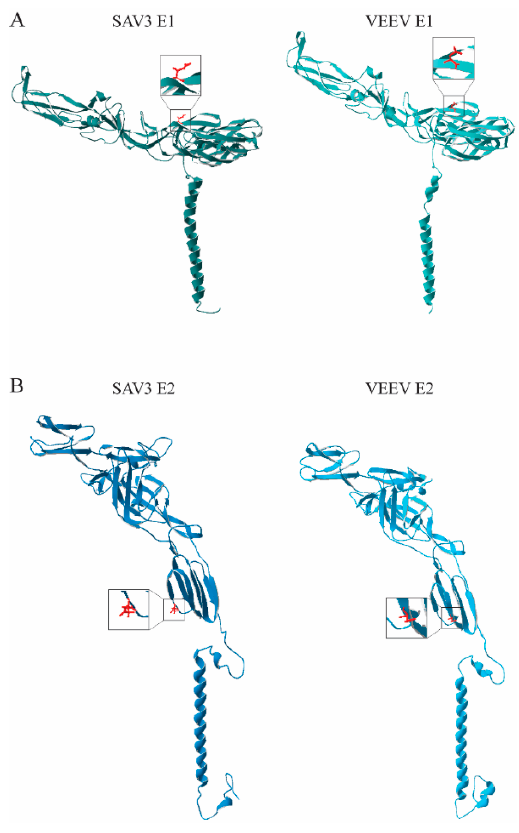
Figure 2. Ribbon diagrams of the modeled SAV3: ( A ) E1 and ( B ) E2 proteins compared with that of the best fitting templates, VEEV E1 and E2 (PDB IDs: 3J0C_A, 3J0C_B), as predicted by I-TASSER. Asparagine side chains on SAV3 E1 (N 35 ) and E2 (N 319 ) were predicted to be involved in N-linked glycosylation, and the corresponding sites on VEEV E1 (N 134 ) and VEEV E2 (N 318 ), are shown in red.